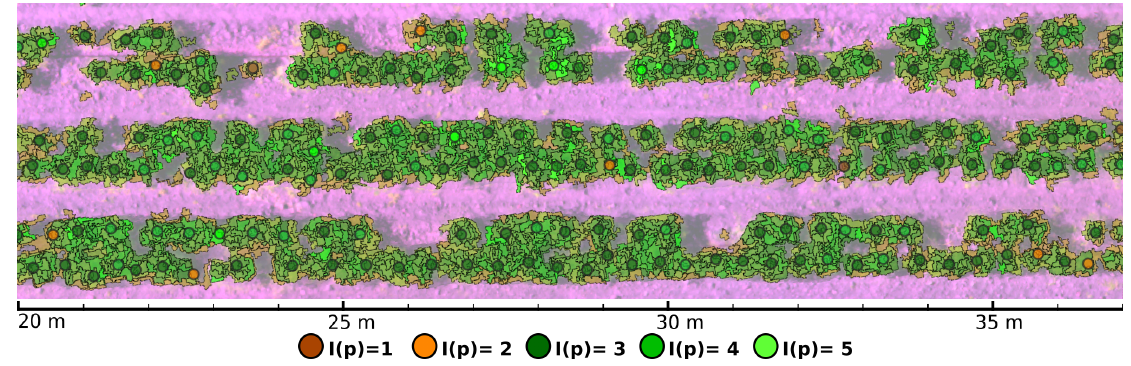
Figure 5. Health indices I(p) for estimated seeding points.